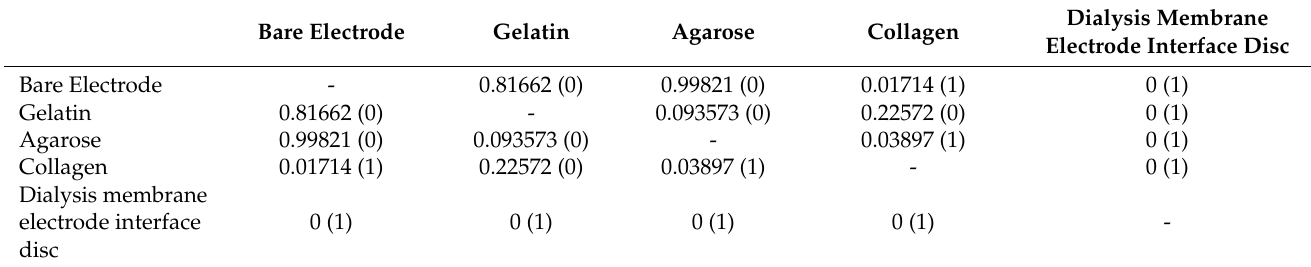
Table 1. Comparative analysis among different membranes. p -value for each pair of data analyzed using one-way ANOVA. The significance value (0, 1) provided in parenthesis beside the p -value denotes the significance of each pair of data. Significance value 1 indicates that the data pairs are significantly different ( p -value lesser than 0.05). The significance value 0 depicts that the data pairs are not significantly different ( p -value greater than